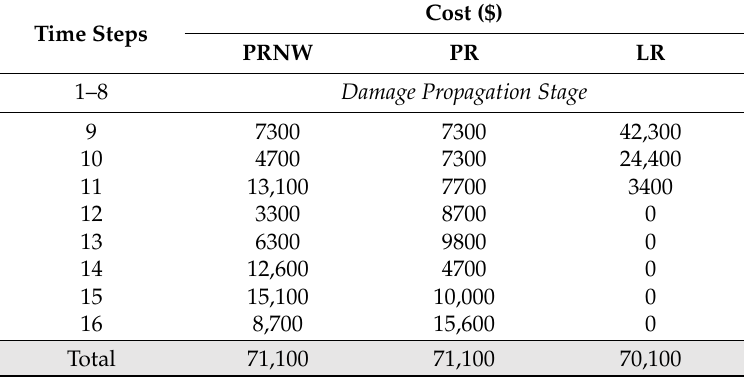
Table 5. Recovery cost during each recovery